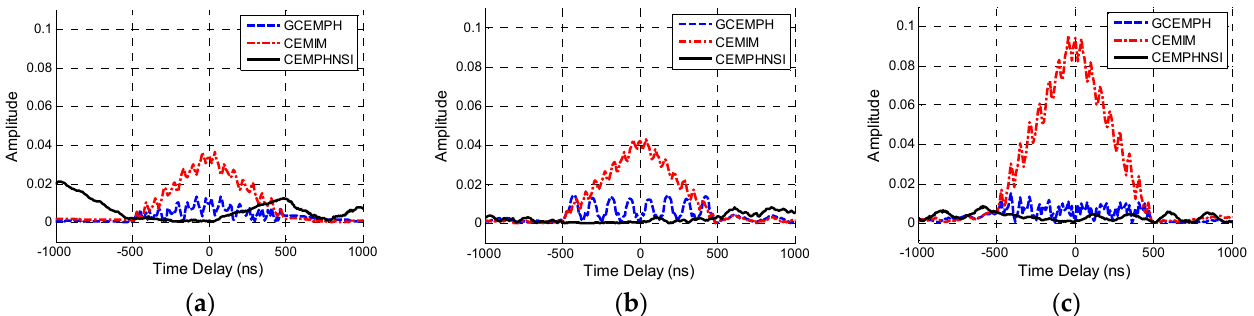
Figure 8. ( a ) The correlation between 3 extra signals and signal s 1 ; ( b ) The correlation between 3 extra signals and signal s 2 ; ( c ) The correlation between 3 extra signals and signal s 3 .